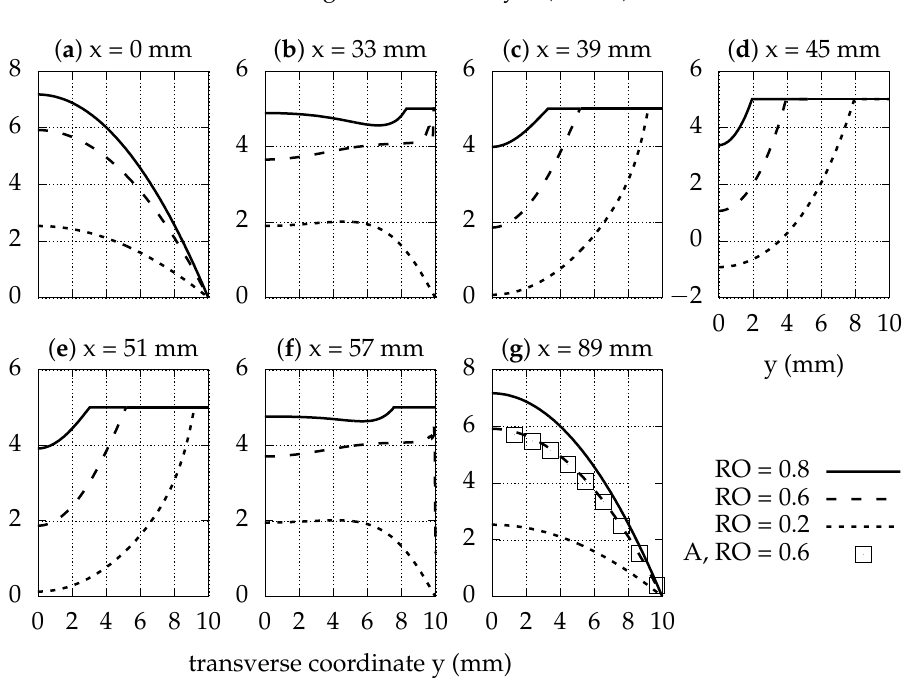
Figure 4. Longitudinal velocity profiles at successive longitudinal positions x ( a – g ) for various values of RO and for c = 5 mm/s, n = 1 and one roller. Comparison with existing results (A: Data from [12]) is presented. Table 1. Transport efficiency ( TE ) for various pumping conditions and pump length L = 90 mm. Comparison with existing results